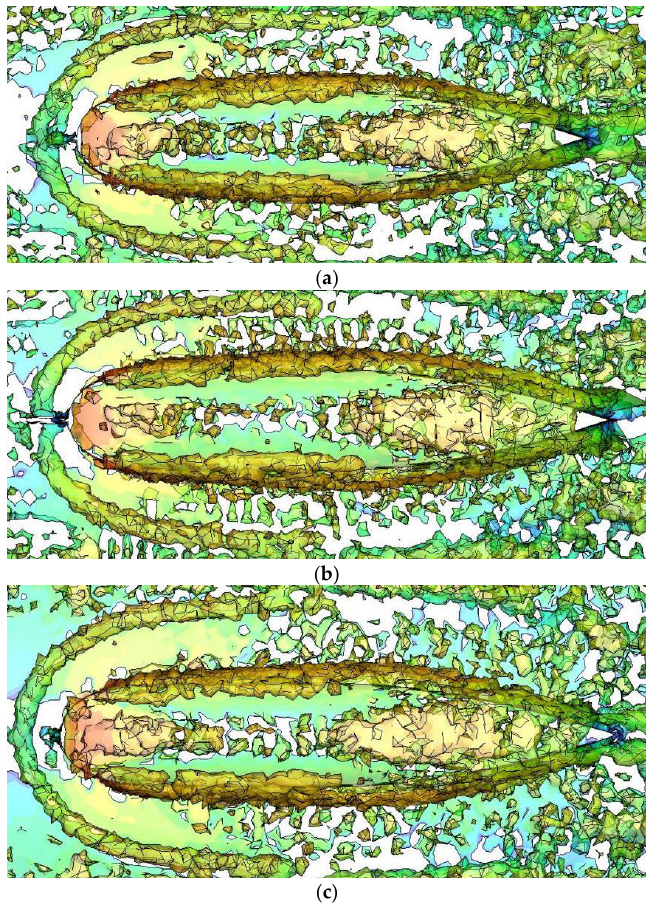
Figure 18. The diagram of the horseshoe vortex after the application of leading-edge serrations of different amplitudes. ( a ) A = 0.025c; ( b ) A = 0.05c; ( c ) A =